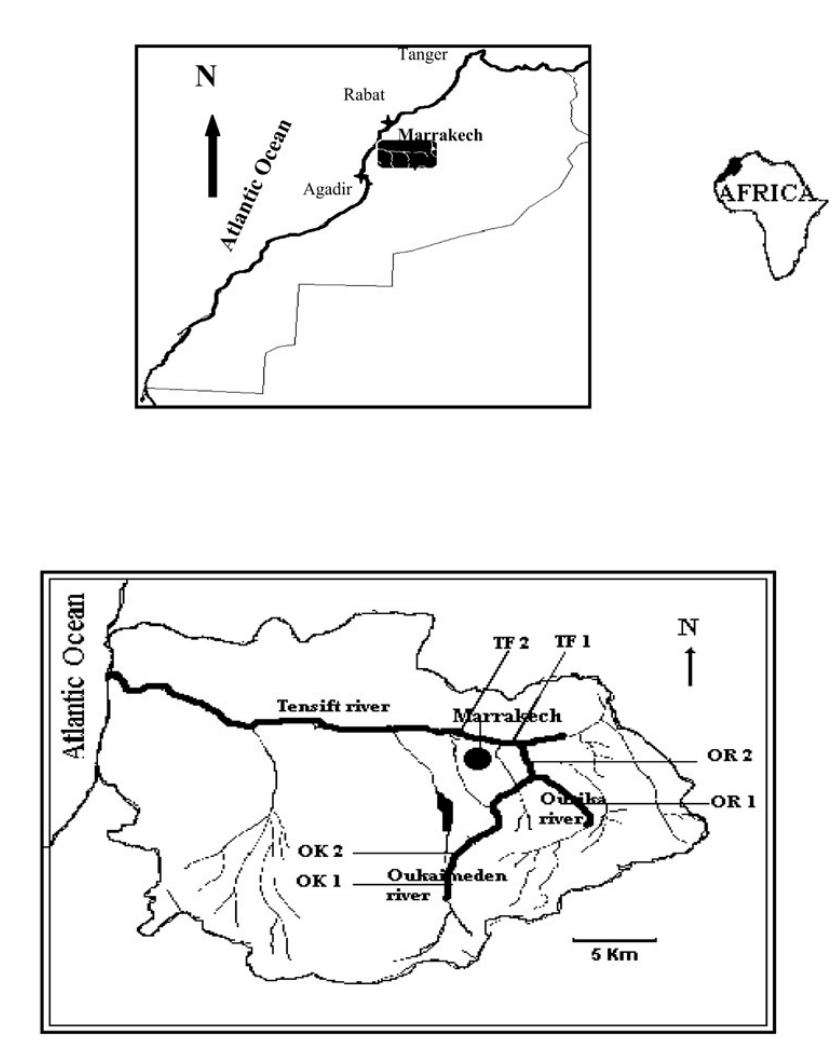
FIGURE 1 . Map of Morocco indicating locations of sampling sites in the Oukaimeden, Ourika, and Tensift Rivers.